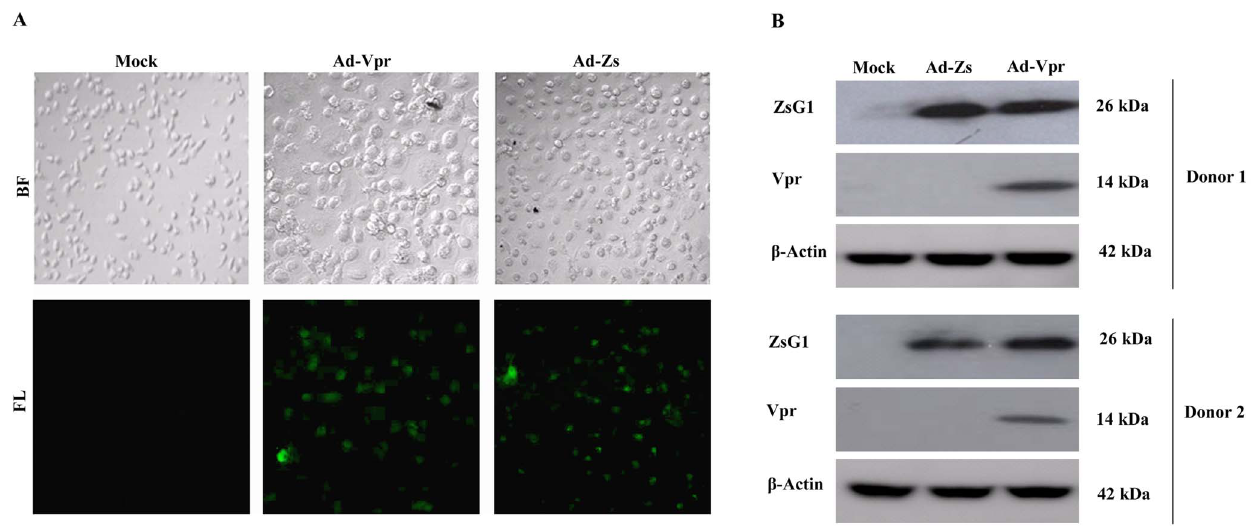
Figure 2. Expression analyses of HIV-1 Vpr protein in human monocyte-derived macrophages (MDMs). (A) Peripheral blood mononuclear cells (PBMCs) were isolated from two healthy donors through leukophoresis, cultured in vitro , and differentiated into MDMs as described in Materials and Methods. At day 7, the MDMs were infected with either Ad-Vpr or Ad-Zs, or were left untreated as mock-infected controls (left). At 48 h post-infection, the cells from Donor 1 were visualized by fluorescence (FL) and bright field phase contrast (BF) microscopy. (B) The cells from the two donors (upper panel, Donor 1; lower panel, Donor 2) were lysed and subjected to Western blot analyses using Vpr, ZsGreen1, and b - actin antibodies.